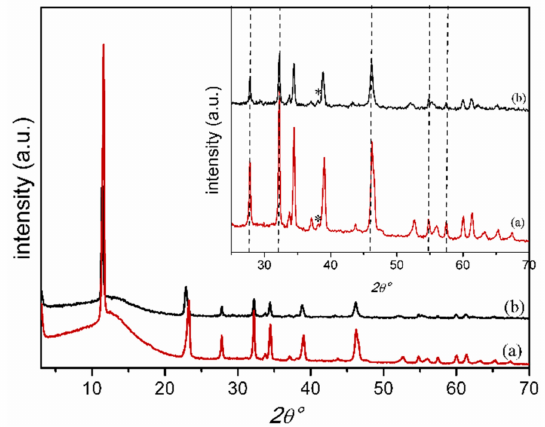
Figure 7. XRD of LDH3 ( a ) and LDH1 ( b ) after the photocatalytic experiments. The spectral regions from 25 to 70 2 θ ◦ have been magnified ten times. AgCl (dashed lines), Ag